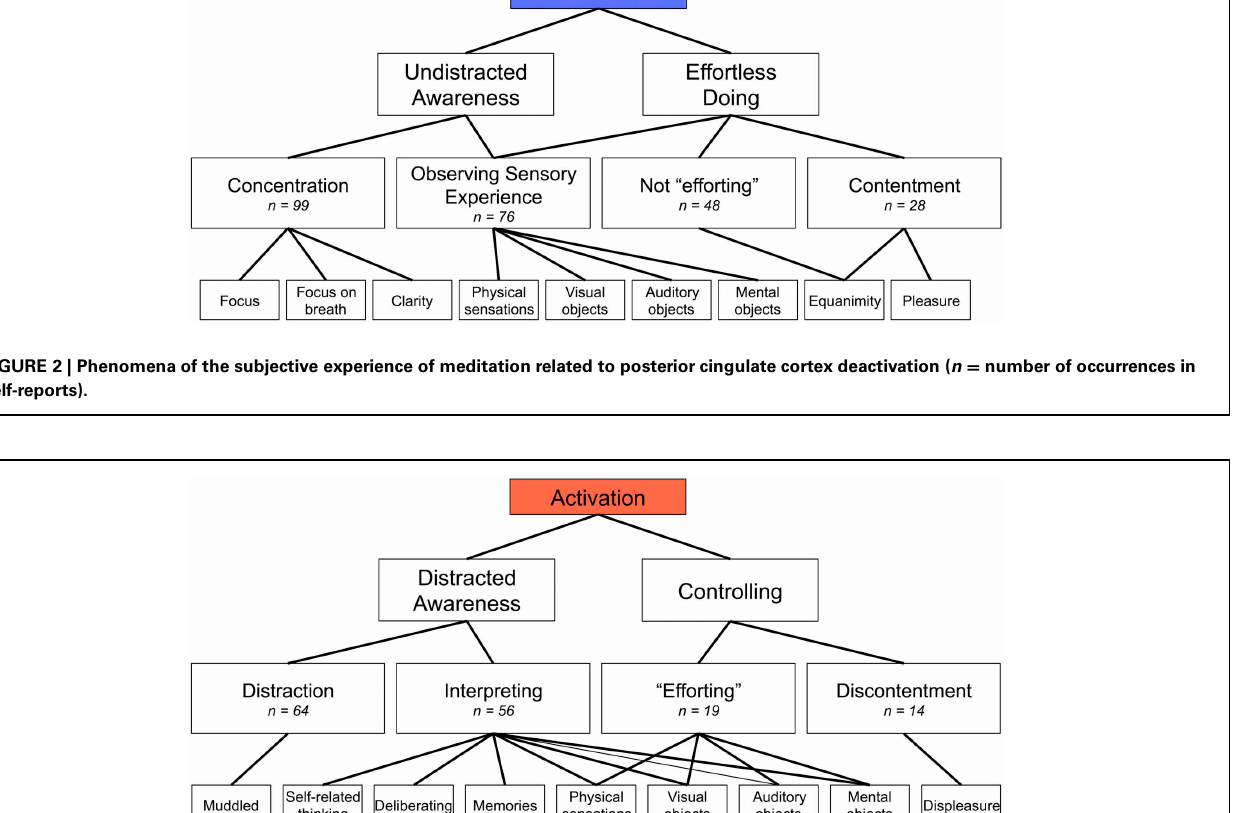
FIGURE 3 | Phenomena aspects of the subjective experience of meditation related to posterior cingulate cortex activation ( n = number of occurrences in self-reports).